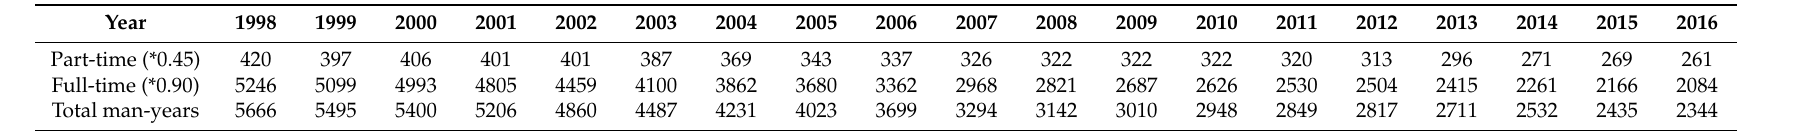
Table 1. Man-years in the Danish fishing fleet